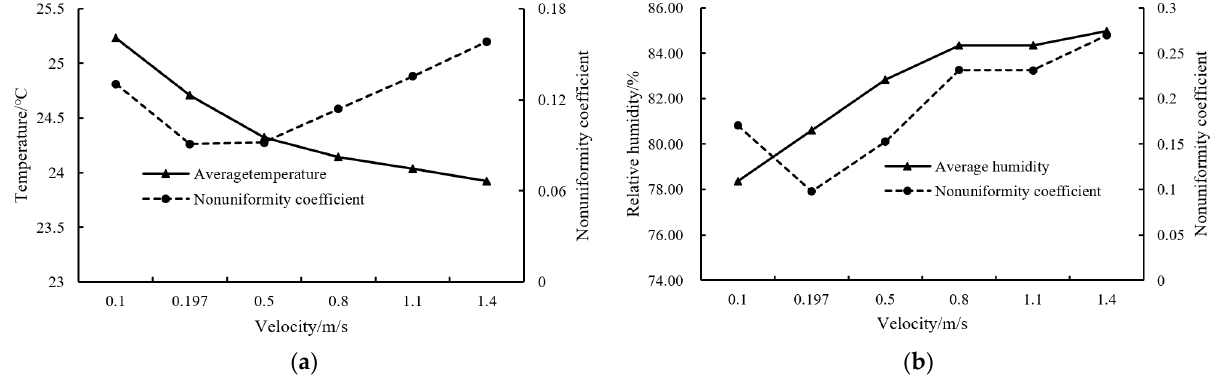
Figure 10. Effect of different velocities on ( a ) temperature and ( b ) relative